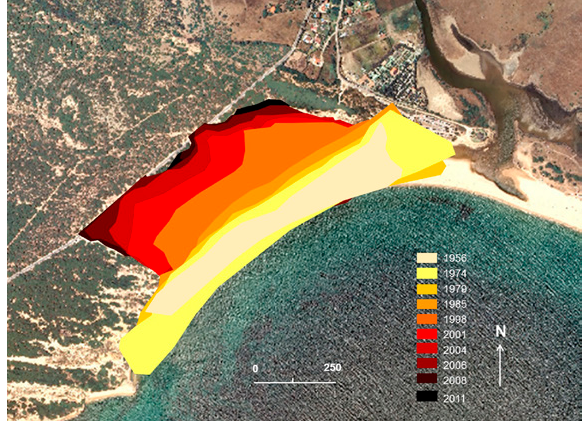
9. – Evolution of the Valdevaqueros dunefield from 1974 to